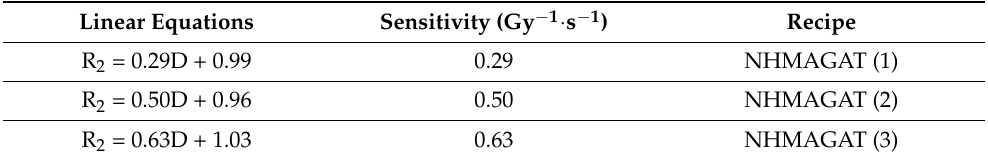
Figure 2. Dose sensitivity value for different CaCl 2 concentrations. Table 1. Linear equations and sensitivities of curves in Figure 1b.